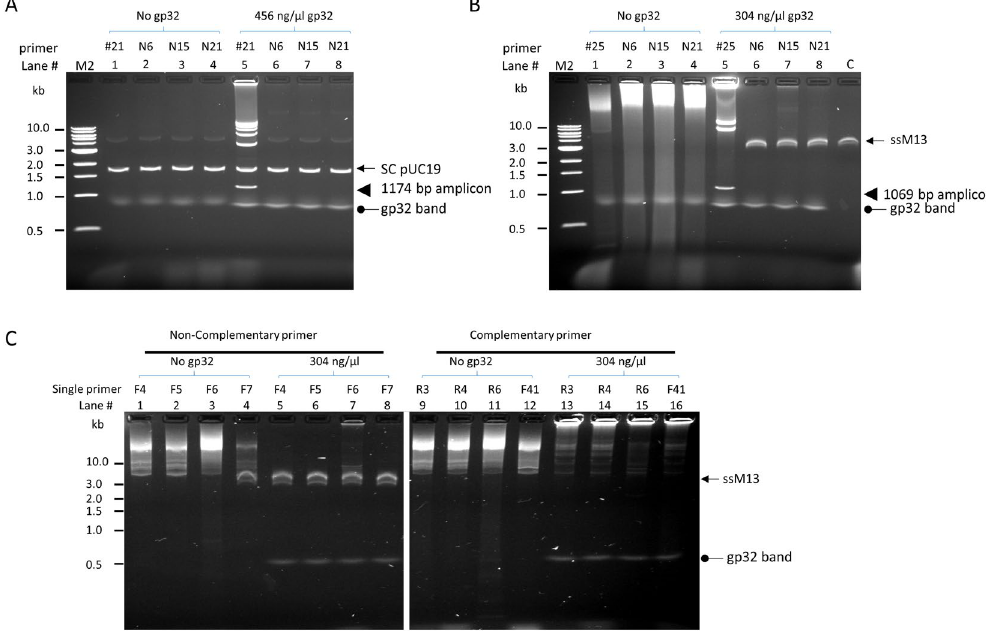
Figure 5. Probing the role of gp32 in conferring amplification specificity. Specific or non-specific primers were used to perform typical amplification reactions with 0.1 µ g pUC19 or ssM13 DNA. ( A ) pUC19 dsDNA template with specific and random primers. Primer pair #21 produced specific product only in the presence of gp32 (lane 1 vs 5). Random primers of various length (N6, N15 or N21) gave no product regardless of the presence of gp32 (lane 2–4 and 6–8). ( B ). M13 ssDNA template with specific and random primers. Without gp32, high molecular weight smear products were generated with either a primer pair or random primers (lanes 1–4). With gp32, primer pair #25